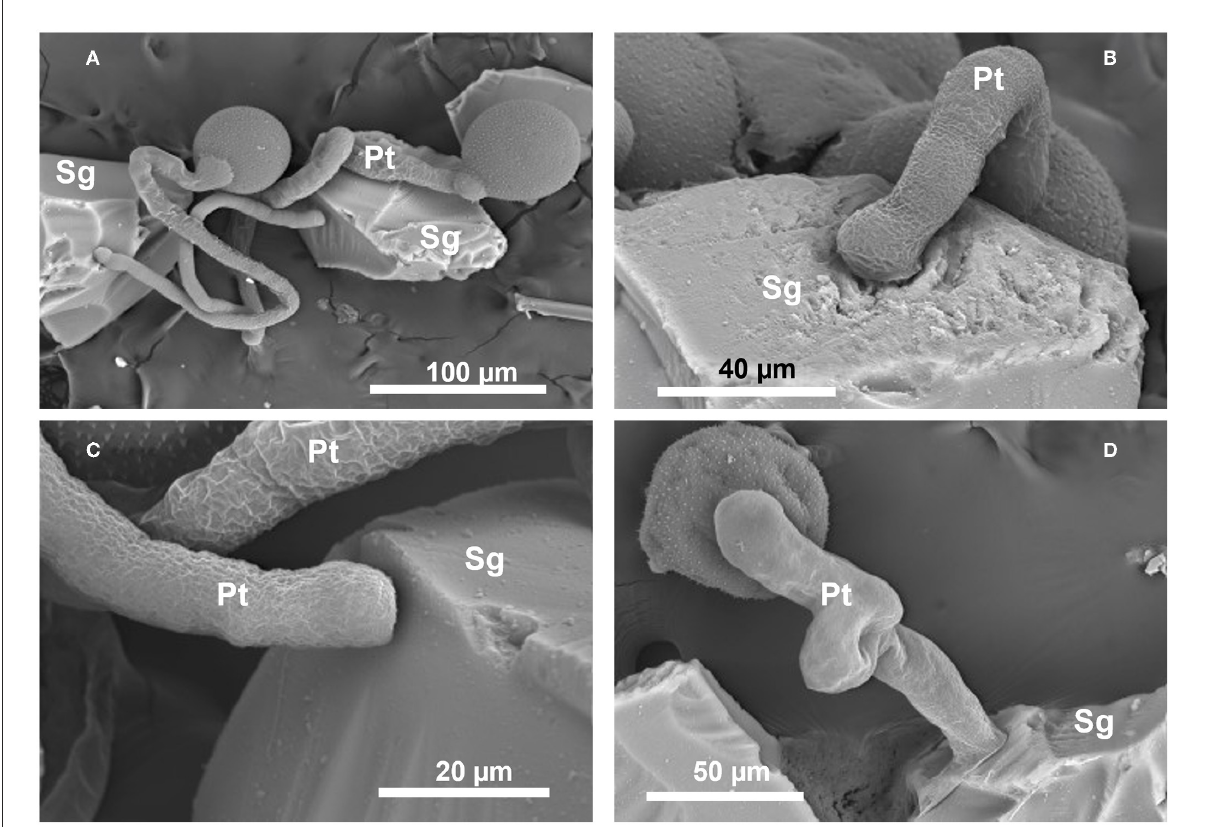
FIGURE1 Scanning electron micrographs of in vitro germination and tube growth (Pt) of Crocus vernus subsp. vernus pollen on the Silica gel scales (Sg) at SEM. (A) Long pollen tubes. (B) Pollen tube growing with the apex inside a hollow of the Silica scale. (C) Pollen tube with flattened apex. (D) Extensive flattening of the